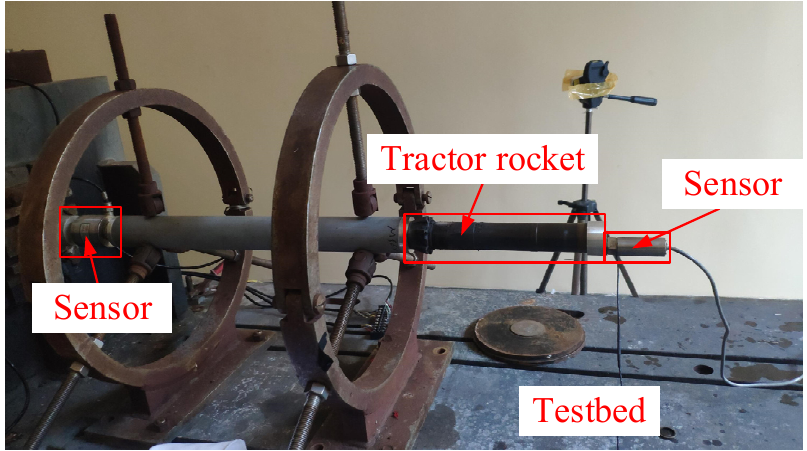
Figure 11. The tractor rocket thrust test layout.